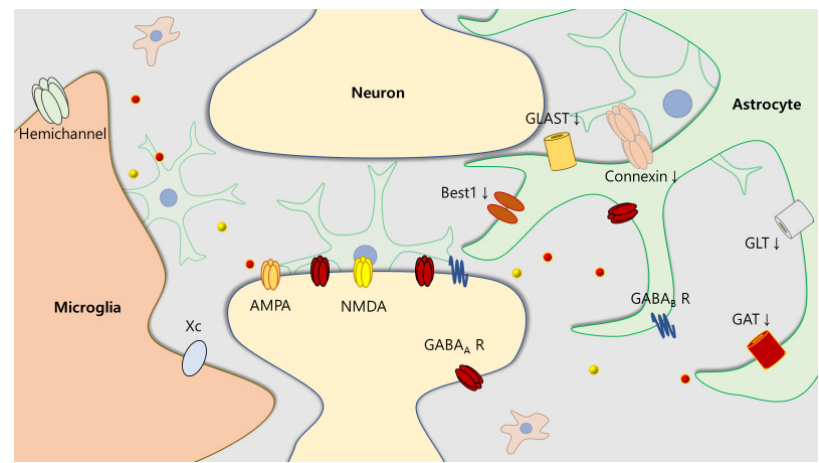
Figure 3. Alteration of transporters and channels in neurodevelopmental disorders. Several transporters and channels on glial cells are responsible for the presence of a pathological state. In the epileptic brain, the expression of glutamate transporter (GLT), glutamate aspartate transporter (GLAST), GABA transporter (GAT) [79], and bestrophin-1 channel (Best1) [12] on astrocytes are decreased ( ↓ ). Changes in GABA receptors have been reported, and neurotransmitters such as glutamate and GABA are diffused by gap junction hemichannels composed of connexins [145] or microglial hemichannels [119].